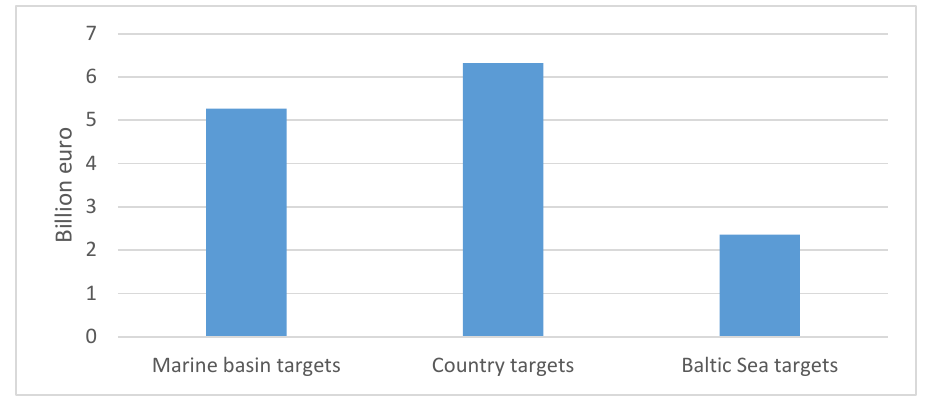
Figure 1. Total costs for marine basin, country targets, and overall N and P reductions.